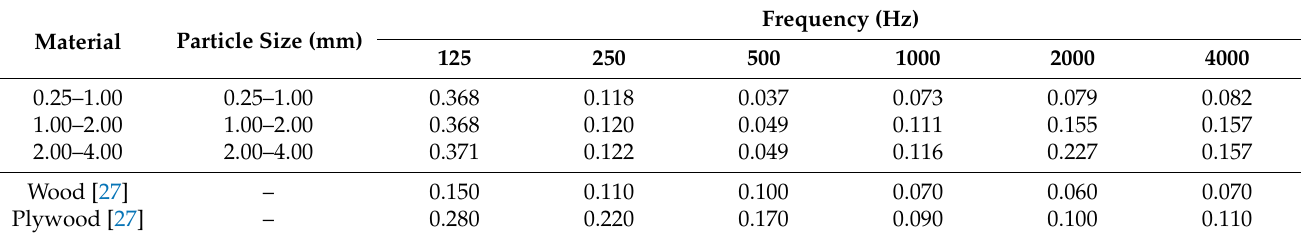
Table 5. Acoustic absorption coefficient according to frequency.